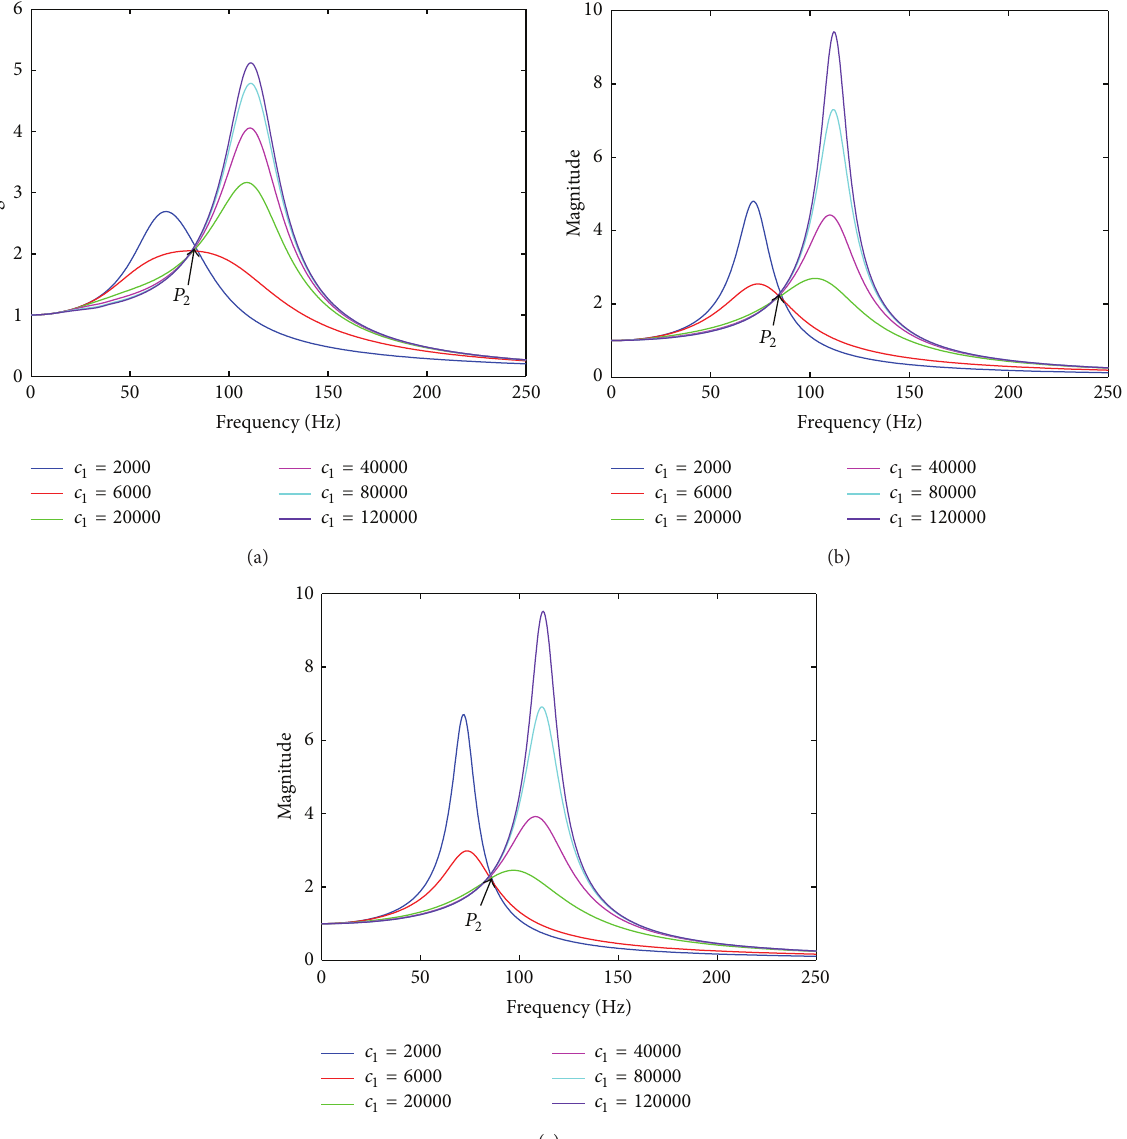
are superior to the Maxwell model in the frequency range from 5 Hz to 20 Hz. However, the Maxwell model has more advantages at high frequencies. Moreover, the differences of the value of 𝜂 between GNM and CM are little, while the GNM is simpler than the other one. Since the equality of amplitude of excitation force between simulation and test has been achieved, large elastic deformation of fluid reservoir occurs in the low frequency band; thus the nonlinear effect of fluid becomes strong, and the GNM and CM can properly represent the physical vibration of isolator. However, in the high frequency band, the Maxwell model has more excellent performance because of the small elastic deformation of fluid reservoir. Further, the curves of Figure 8 are entered into the simulation model, and the corresponding force transmissibility curves are shown in Figure